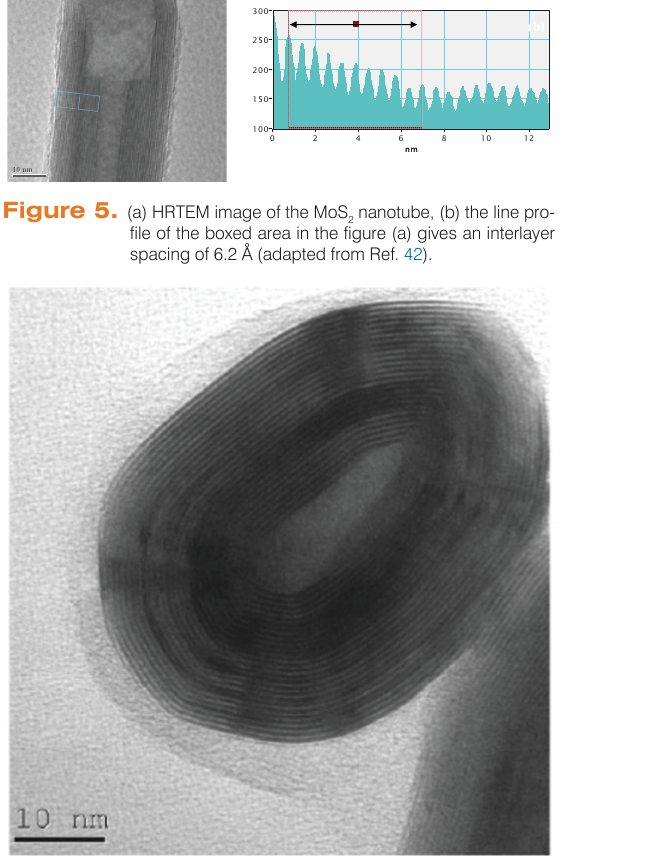
Figure 7. TEM image of a typical fullerene-like WS